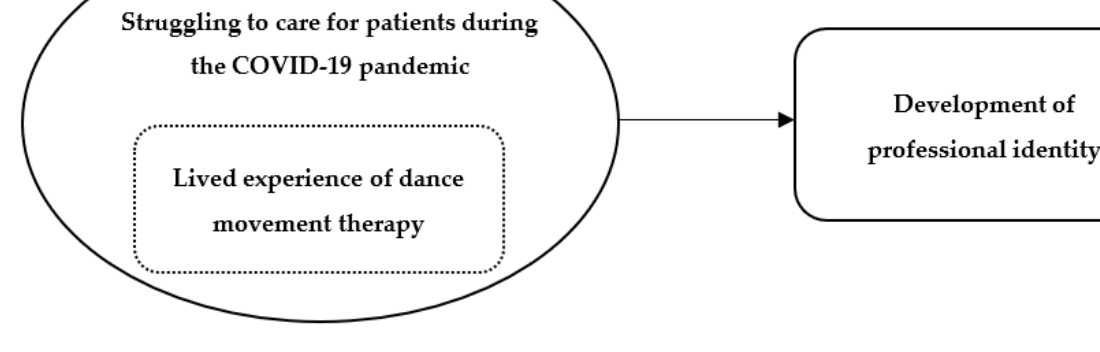
Figure 2. Visual representation of themes.